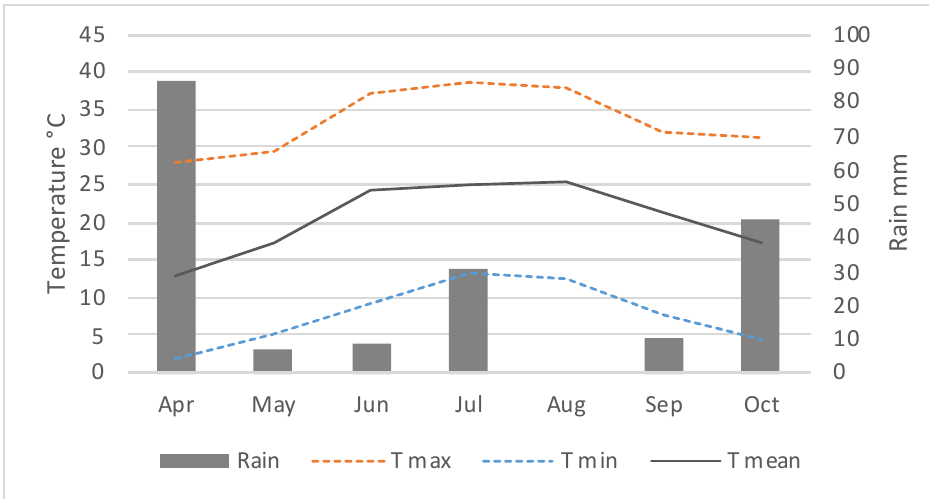
Figure 1. Topographic map of Nemea PDO zone with viticulture areas and the 27 study vineyards.